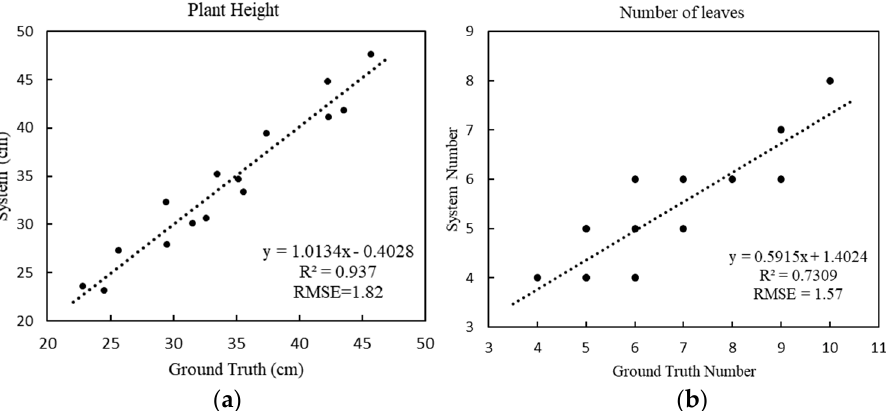
Figure 7. Regression analyses comparing actual height versus estimated height ( a ), and actual leaf number versus estimated leaf number ( b ).